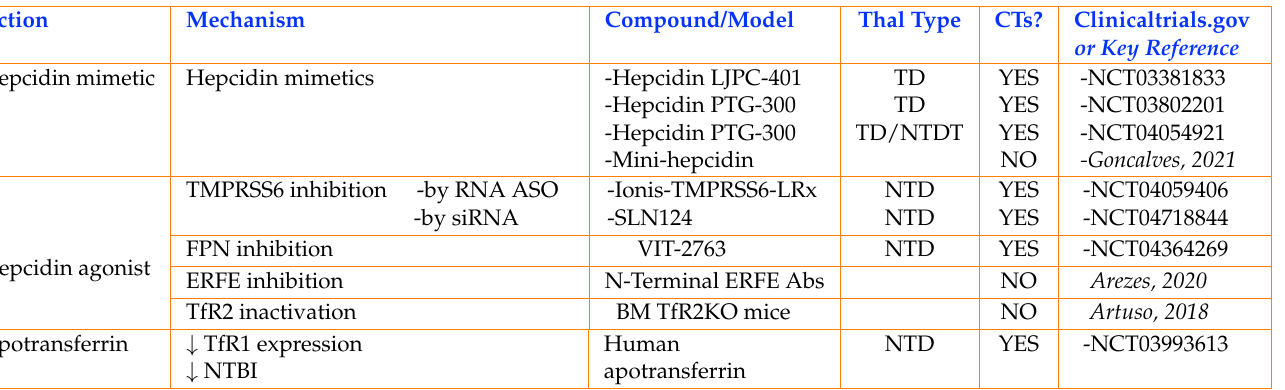
Table 1. Treatments to increase hepcidin function in thalassemia (TD = transfusion-dependent; NTD = non-transfusion-dependent; ERFE = erythroferrone; FPN = ferroportin; HSCT = hematopoietic stem cell transplantation; TMPRSS6 = transmembrane serine protease 6; ASO = antisense oligonucleotide; siRNA = small interfering RNA; NTBI = non-transferrin-bound iron; TfR2 = transferin receptor 2; TfR1 = transferin receptor 1; BM = bone